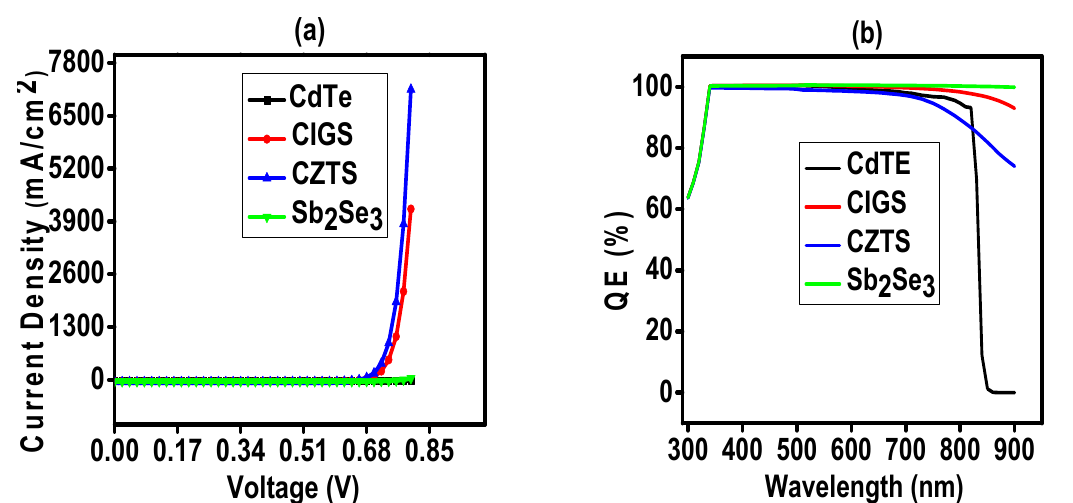
Figure 4. ( a ) I-V characteristic and ( b ) QE characteristics for different absorber layers-based solar structure at optimized conditions.